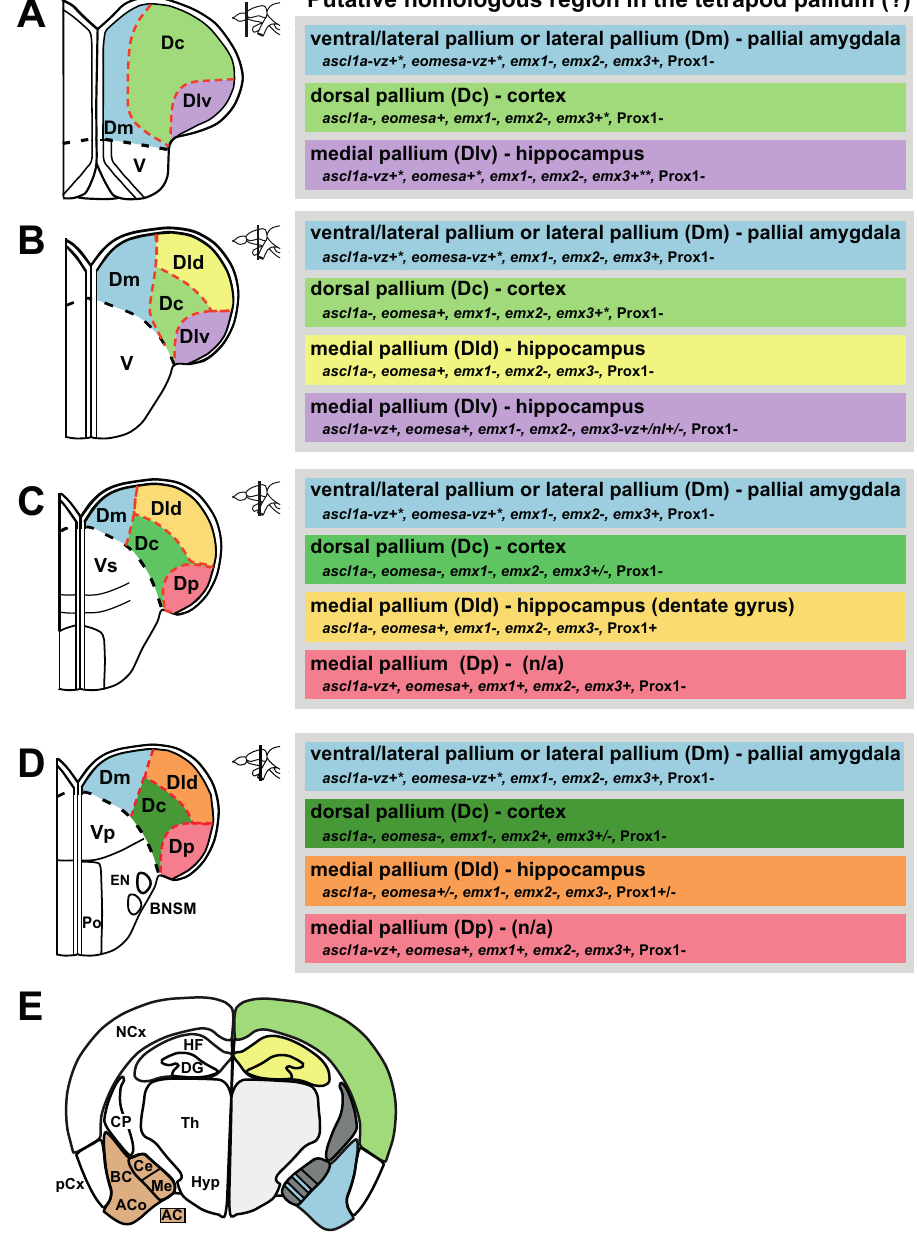
Figure 5. Summary of the gene expression patterns in the adult zebrafish pallium. A .– D . Cross-sections at the levels indicated through the telencephalon. E . Schematic diagram of a cross section through the mouse telencephalon for comparison (modified after 14 ), note that the amygdaloid complex (AC, brown) is derived both from subpallium (grey) and pallium. Light grey areas (Th/Hyp) are part of the diencephalon. Indicated is also a model of the putative homology of the subdivisions in the adult zebrafish pallium to regions in the tetrapod pallium taking the data presented in this paper into account. Additional marker analysis, lineage tracing experiments and functional analyses are necessary to substantiate the proposed homology to pallial nuclei in tetrapods. The different shades of green (Dc) and yellow (Dld) indicate gene expression changes along the rostro-caudal axis. * in scattered cells, ** in Dlv in the ventricular zone, moving caudally expression in the neuronal layer and ventricular zone, note that Prox1 positive cells are present in Dld shortly before the anterior commissure, n/a = not applicable. The black dashed line indicates the boundary between D and V. The red dashed lines indicate the boundaries between different nuclei in D . AC amygdaloid complex, ACo anterior cortical amygdalar area, BC basal amygdalar complex, BNSM bed nucleus of the stria medullaris, Ce central amygdala, CP Caudateputamen, DG dentate gyrus, EN entopeduncular nucleus, HF hippocampal formation, Hyp hypothalamus, Me medial amygdala, NCx neocortex, pCx piriform cortex, Po preoptic region, Th thalamus, V area ventralis telencephali, Vp postcommissural nucleus of the area ventralis telencephali, Vs supracommisural nucleus of the area ventralis